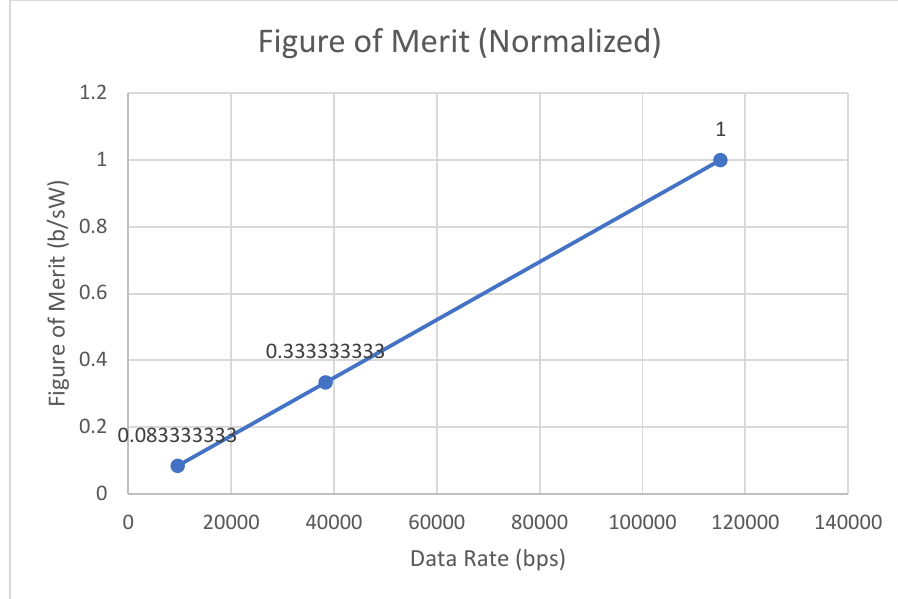
Figure 21. Figure of Merit against data rate at fixed total power.